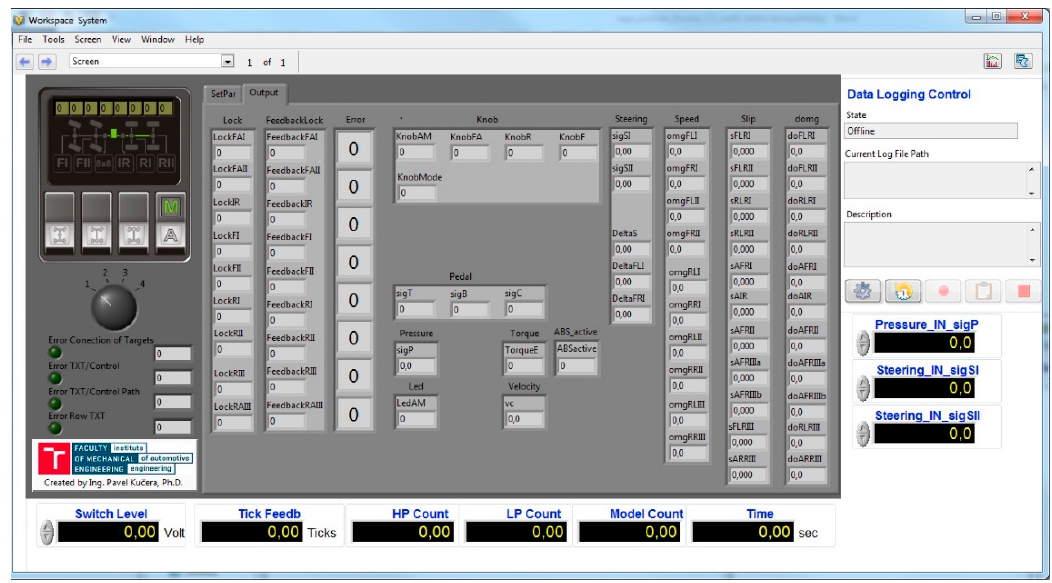
Figure 5. Workspace NI VeriStand software window with customized graphical elements for visualization and control of the algorithm.